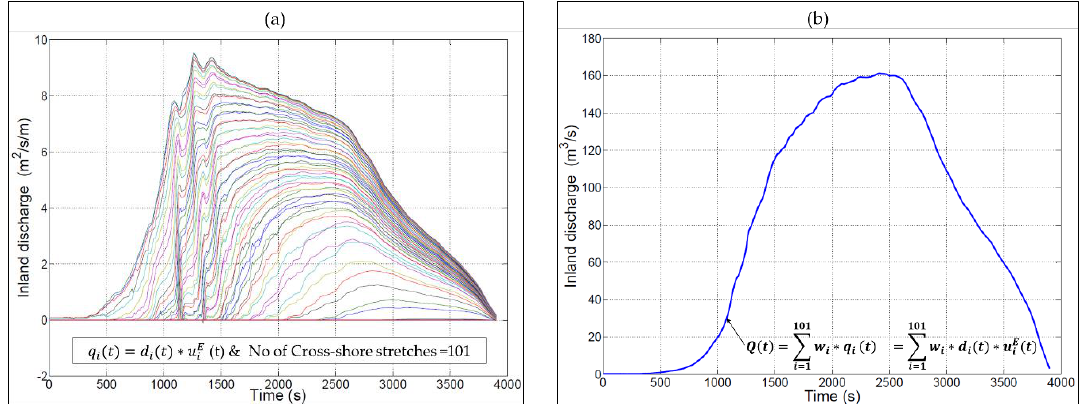
Figure 20. Water discharge calculation through the Zwin dam breach ( a ) discharges q i over the 101 cross-shore stretches and ( b ) total inland discharge Q(t) .